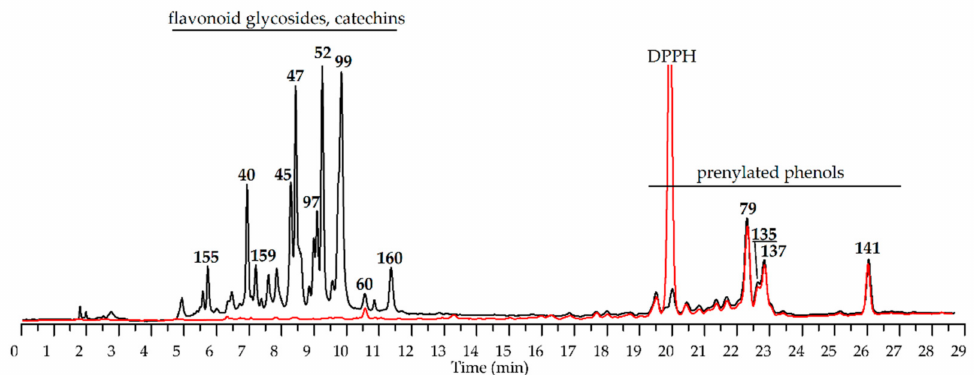
Figure 10. HPLC-UV chromatograms of R. adamsii leave total extract (July sample) before (black) and after preincubation (red) with DPPH • radicals solution. The excess of DPPH • radicals signed as DPPH. The basic peaks are numbered as described in Table